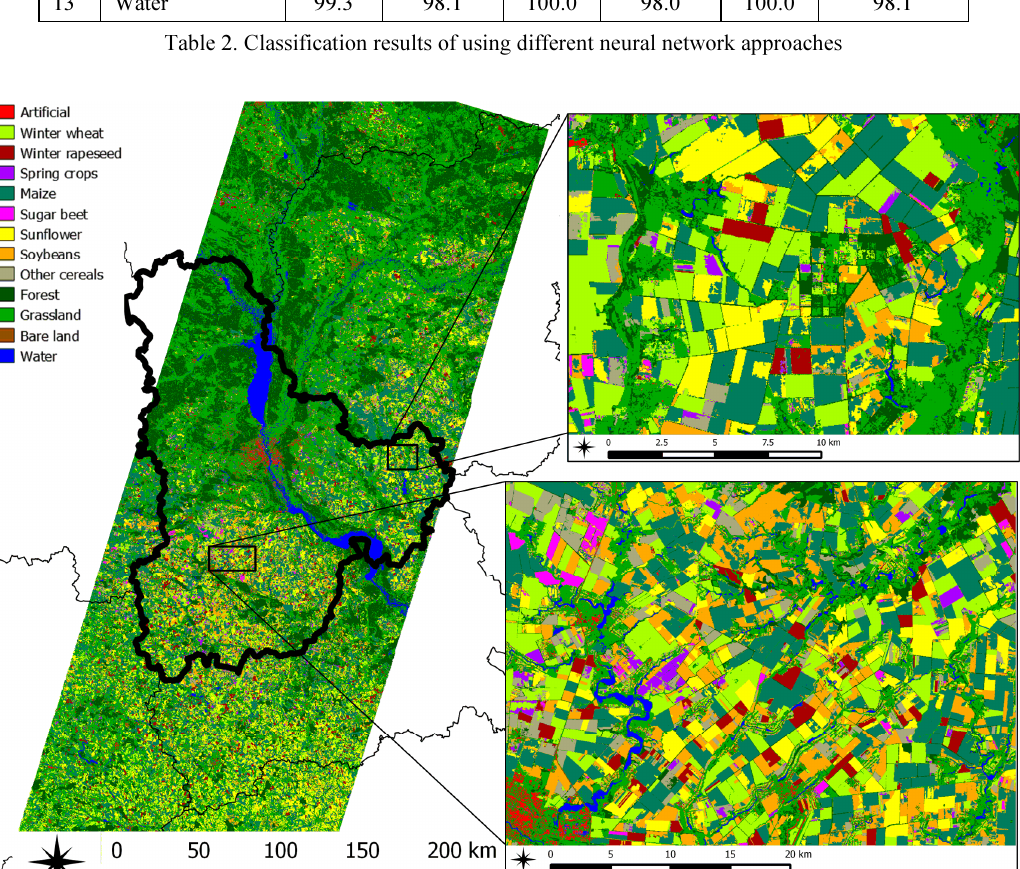
Target accuracy of 85% (in terms of both producer’s and